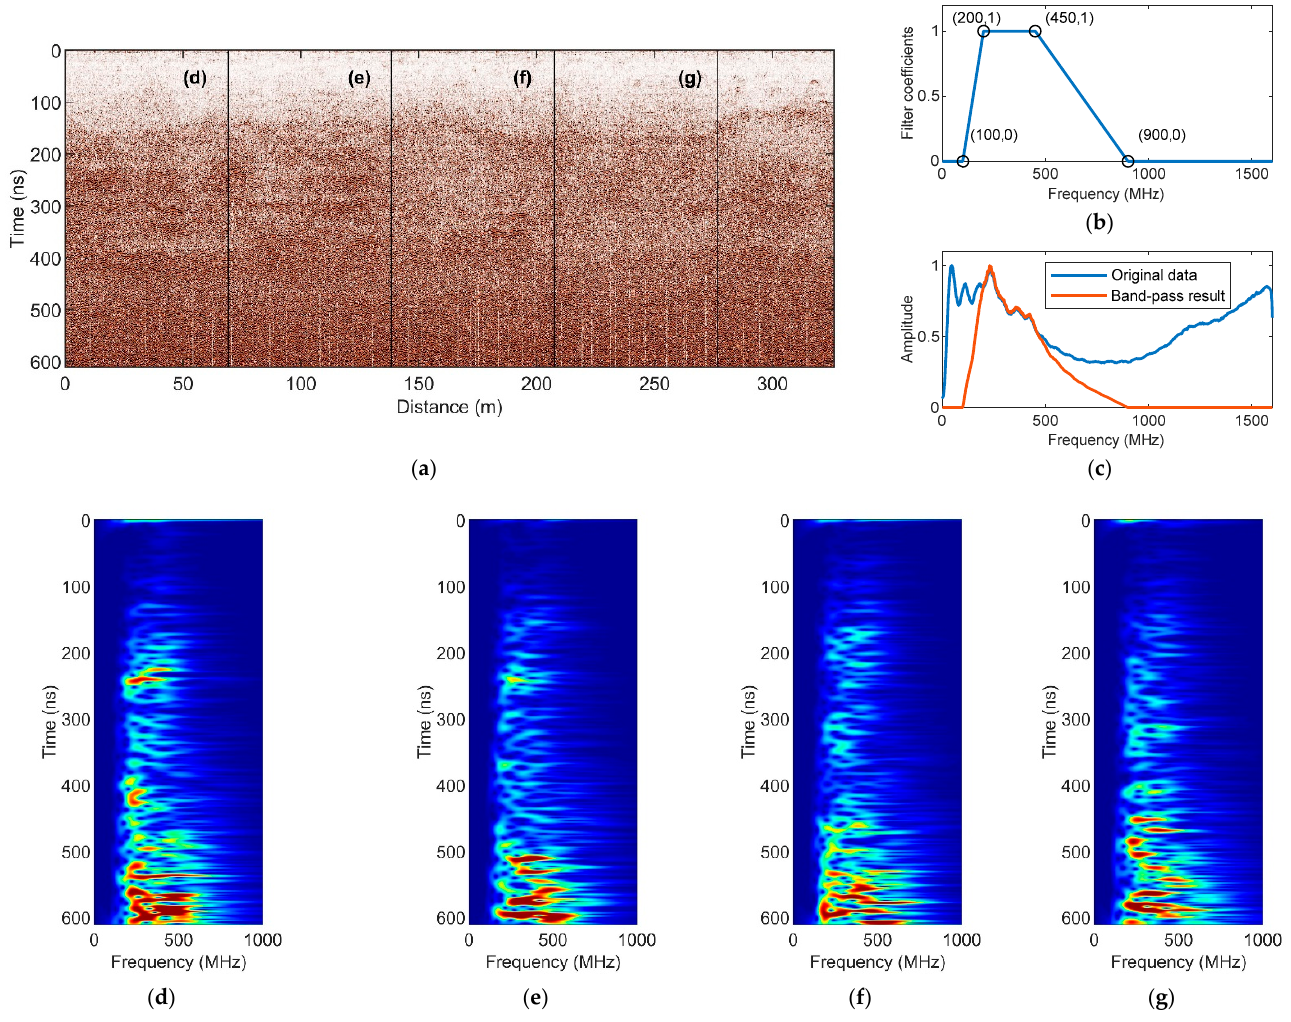
Figure 11. Band-pass filtering test. ( a ) The radargram after band-pass filtering. The signals marked by black lines are the signals used for the S transformation analysis. ( b ) Parameters of the band-pass filter. ( c ) The average frequency amplitude spectrum of the LPR data before and after band-pass filtering. ( d – g ) Present the S transformation results of the marked signals in (a) .